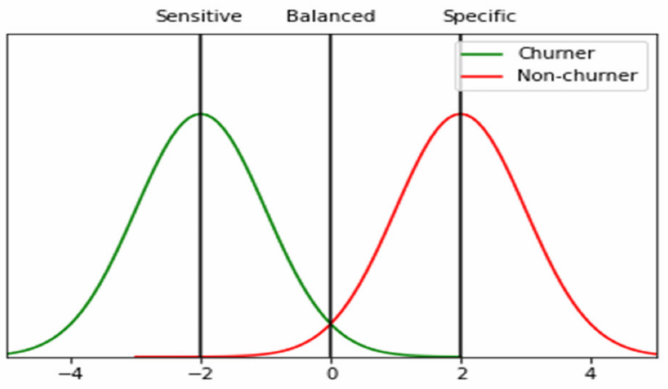
Figure 6. Threshold setting between churner and non-churner in the data set.